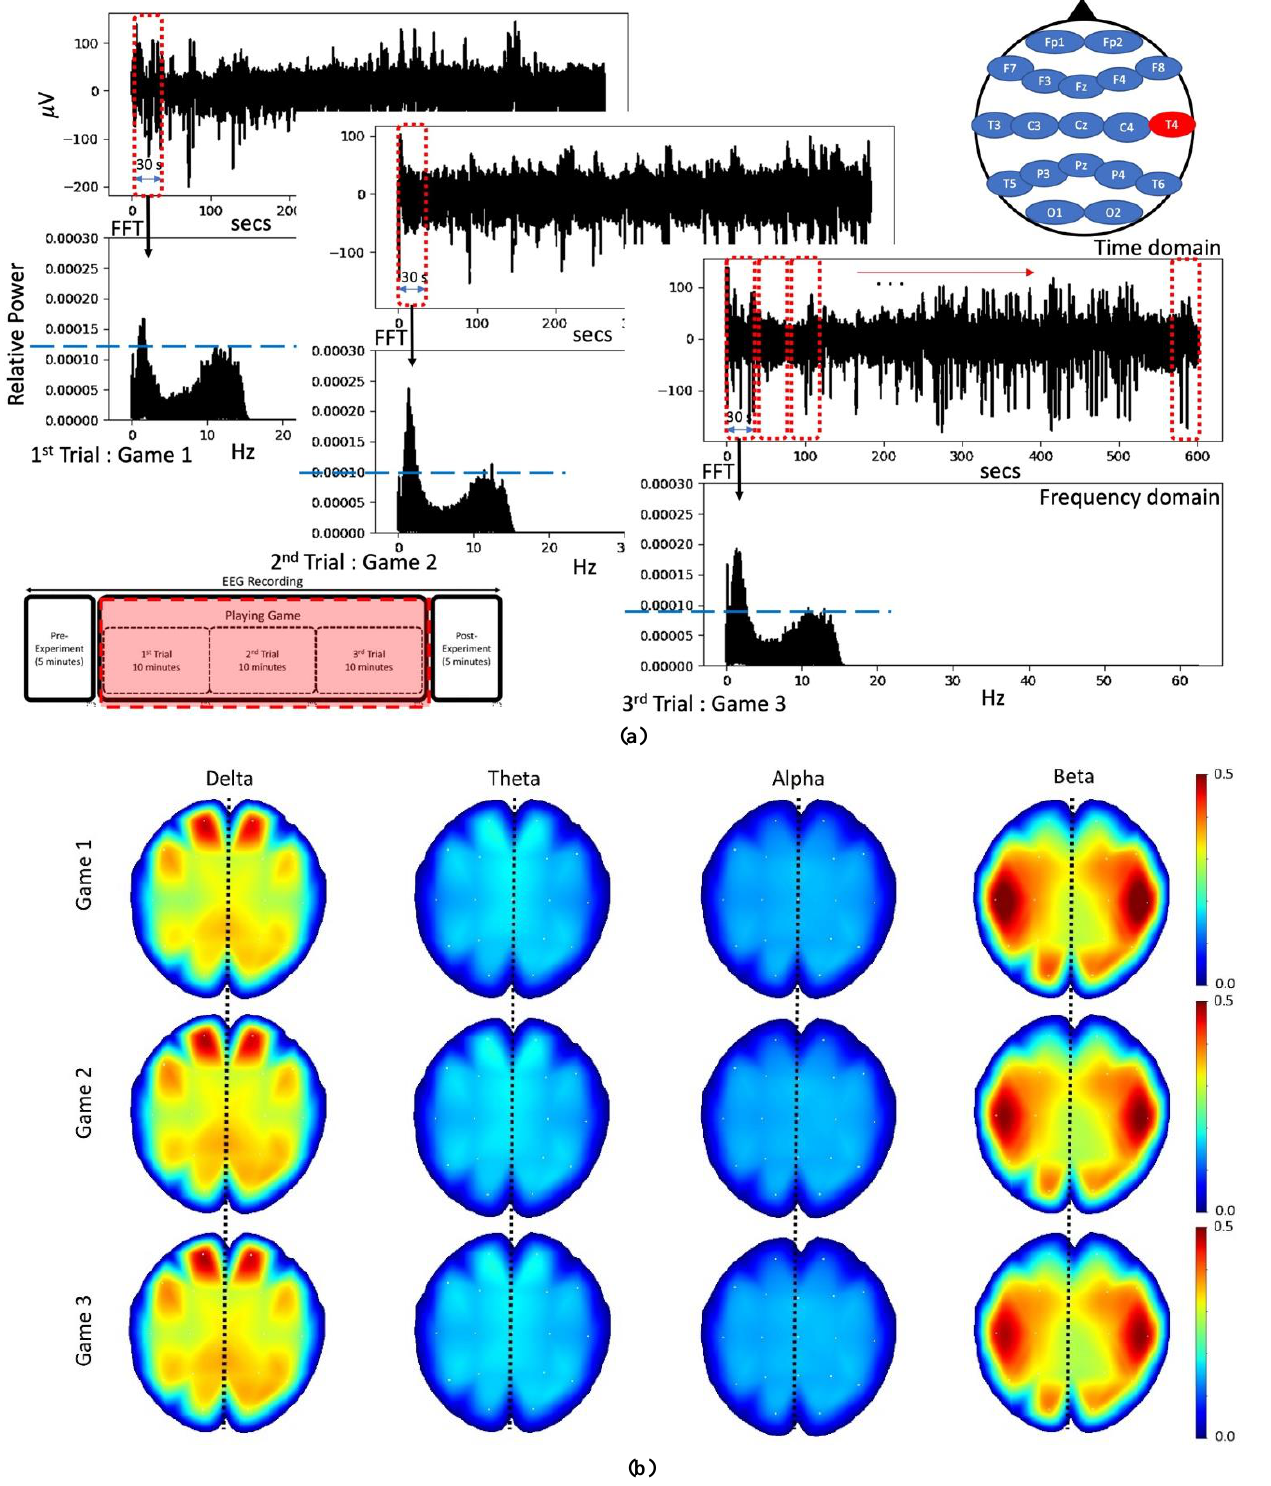
Fig. 4. An example pf relative brain wave changes on a subject during gameplay. (a) The brain waves activity on T3 site during Game 1, Game 2, and Game 3; (b) The topographic map of brain waves (delta, theta, beta, and beta) during Game 1, Game 2, and Game